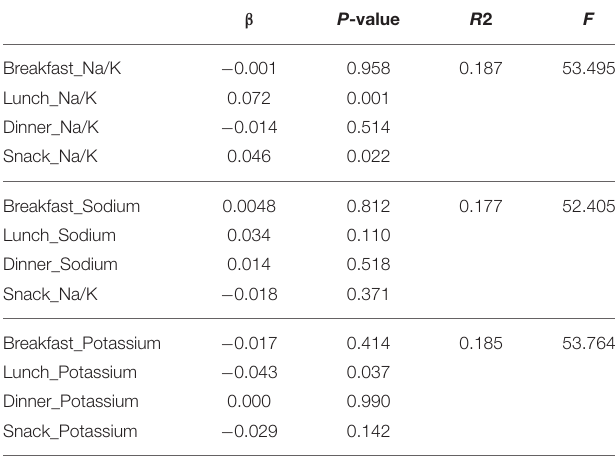
TABLE 3 | Association between the timing of salt intake and blood pressure including